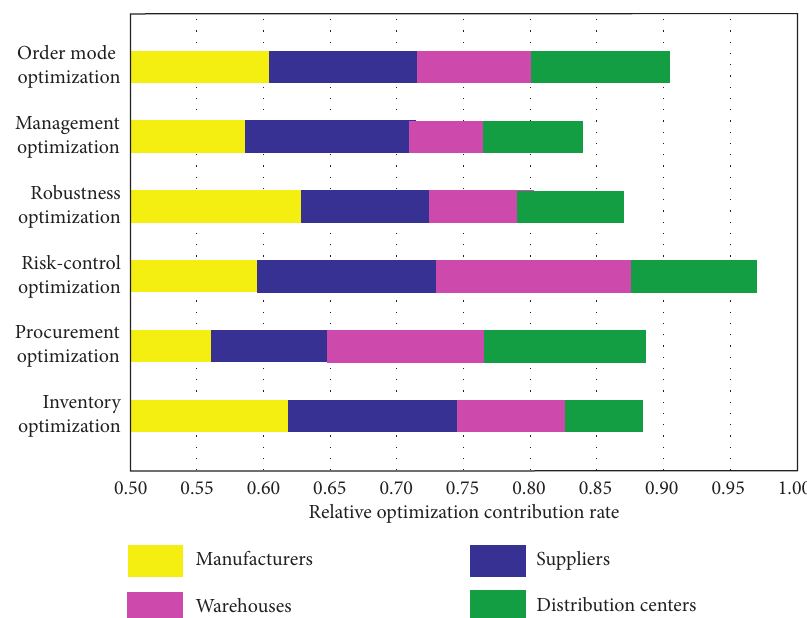
Figure 2: Relative optimization contribution rate of different optimization terms in the IoT-based e-commerce supply chain